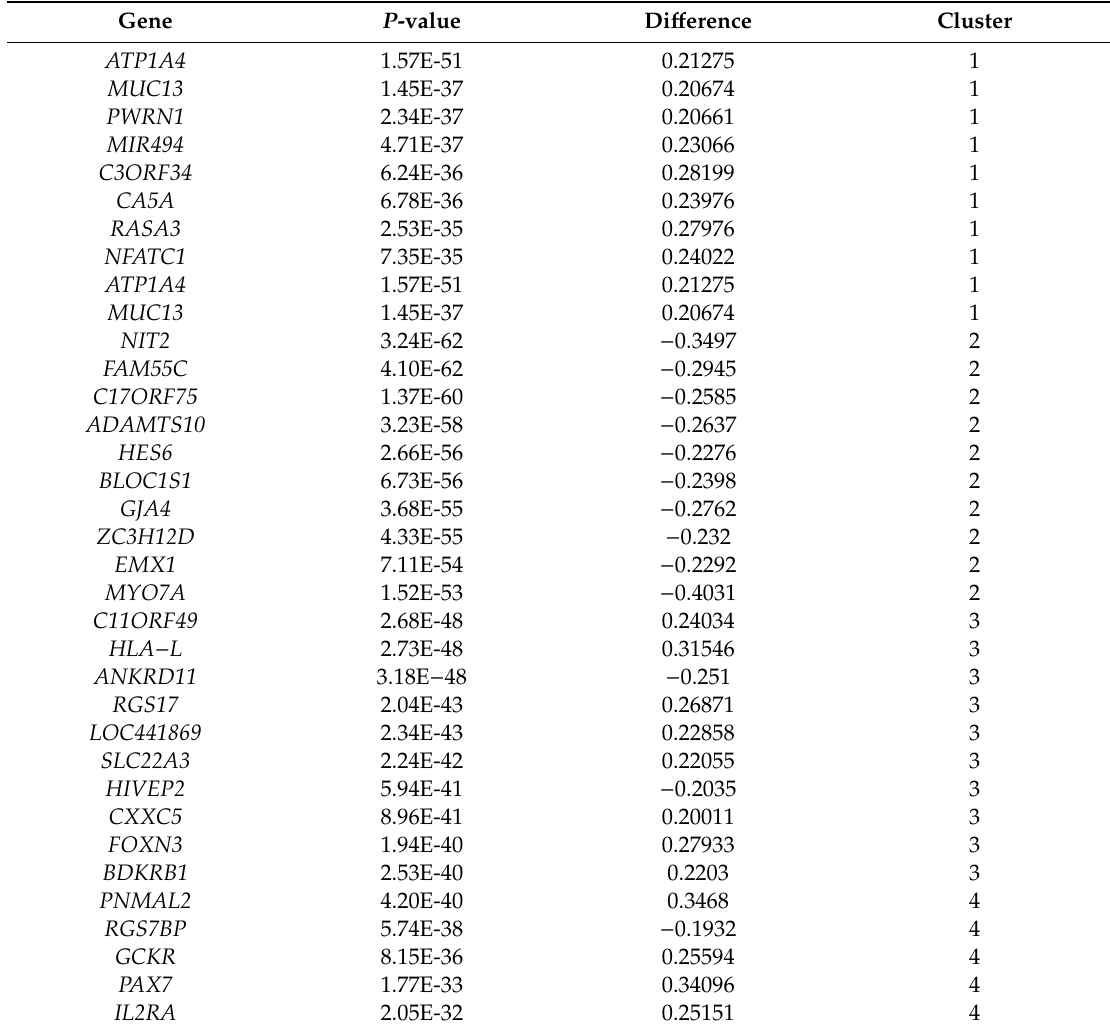
Table 2. List of top 10 marker genes with p ≤ 0.05 (the positive value of the column di ff erence means gene is upregulated in this subtype and vice versa) in each